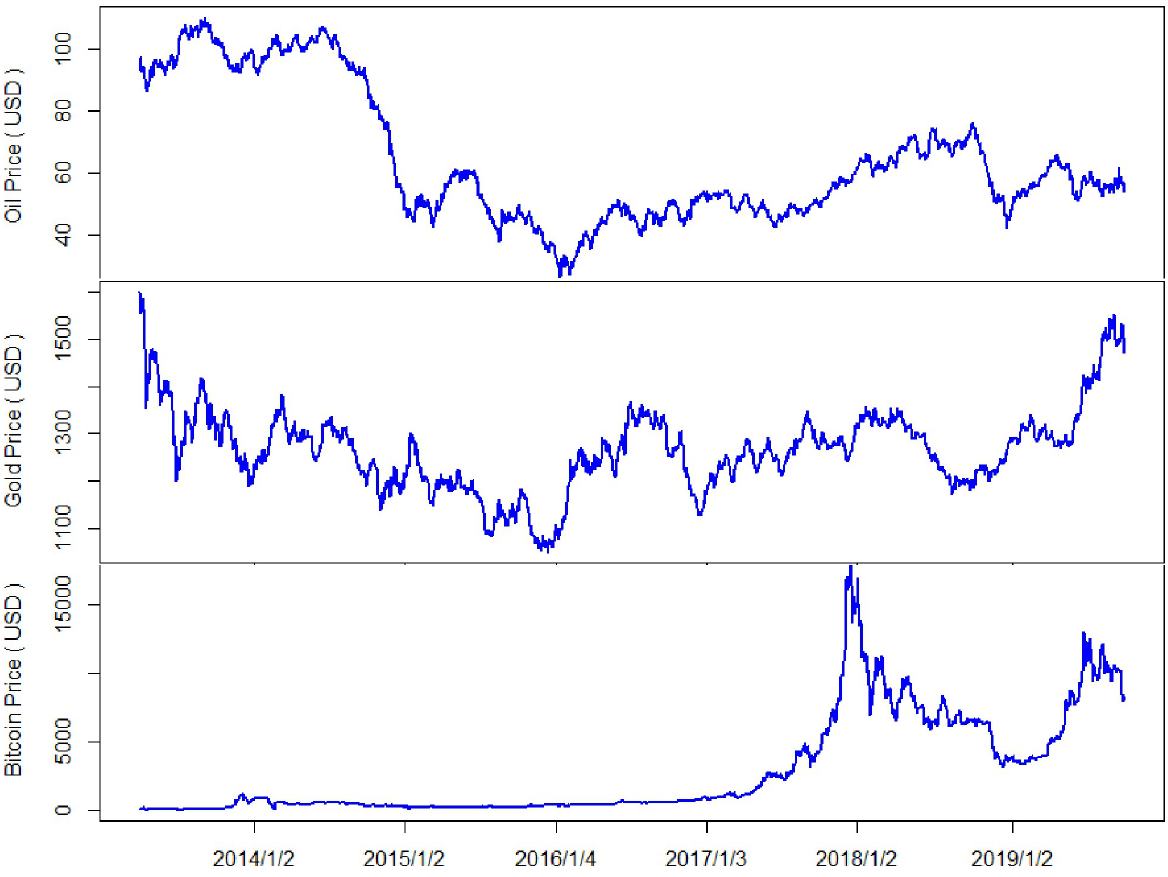
Fig 1. Price dynamics of oil, gold, and Bitcoin from April 2013 to September